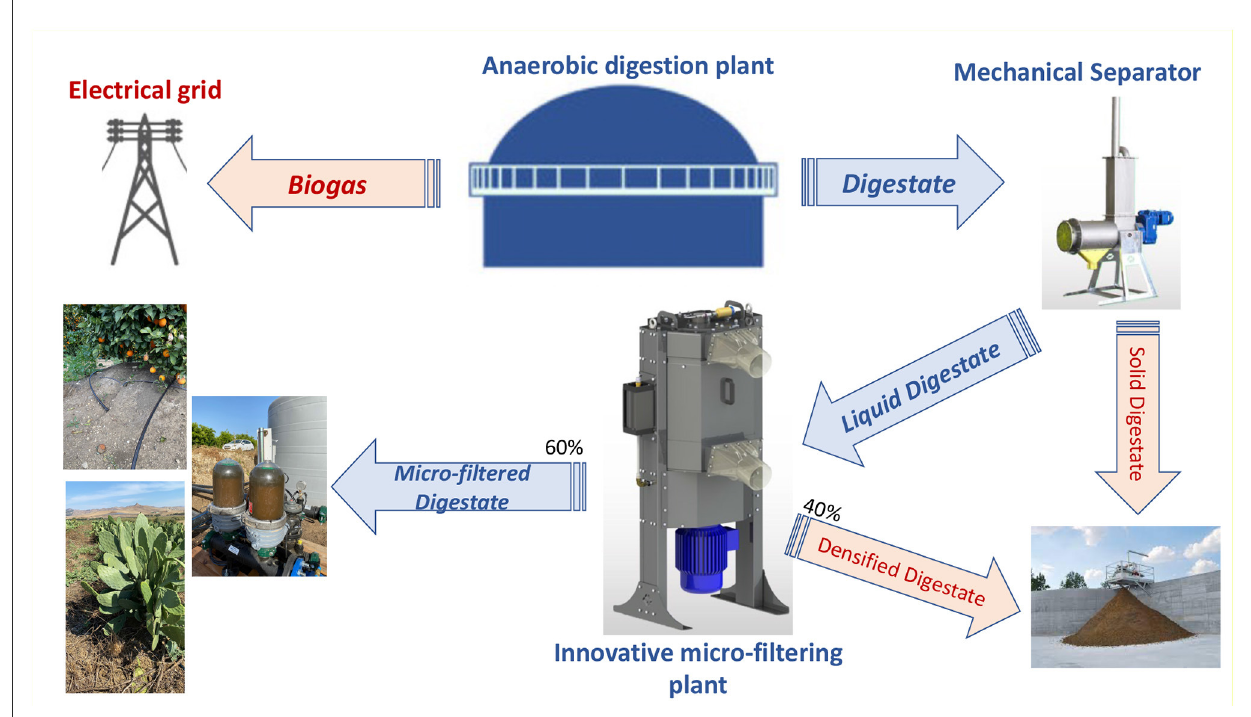
FIGURE1 Micro-filtered digestate production